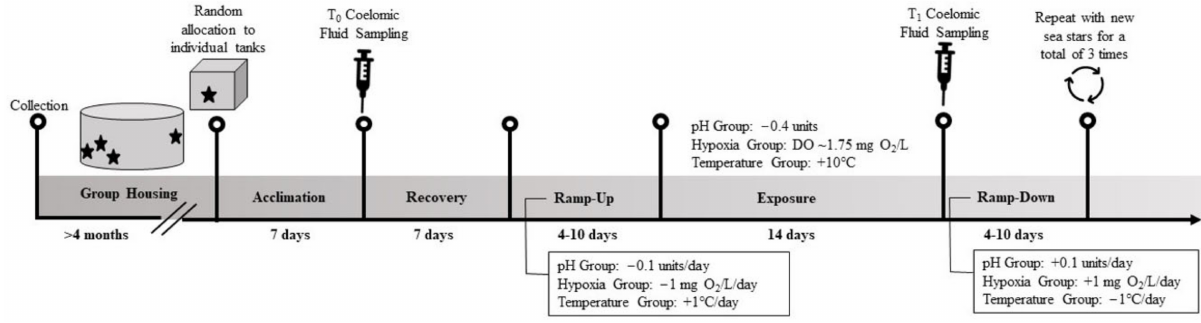
Figure 1. Visual overview of environmental stressor exposure for adult common sea stars ( Asterias rubens